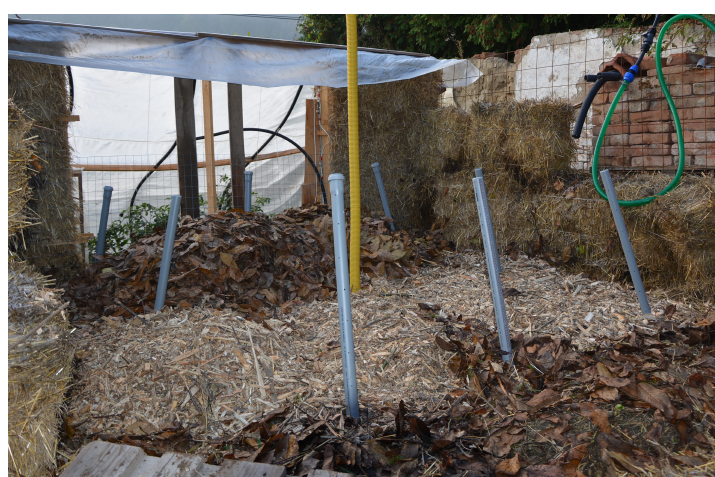
Figure 11. Perforated PVC tubes for enhancing the compost aeration in a vertical direction.